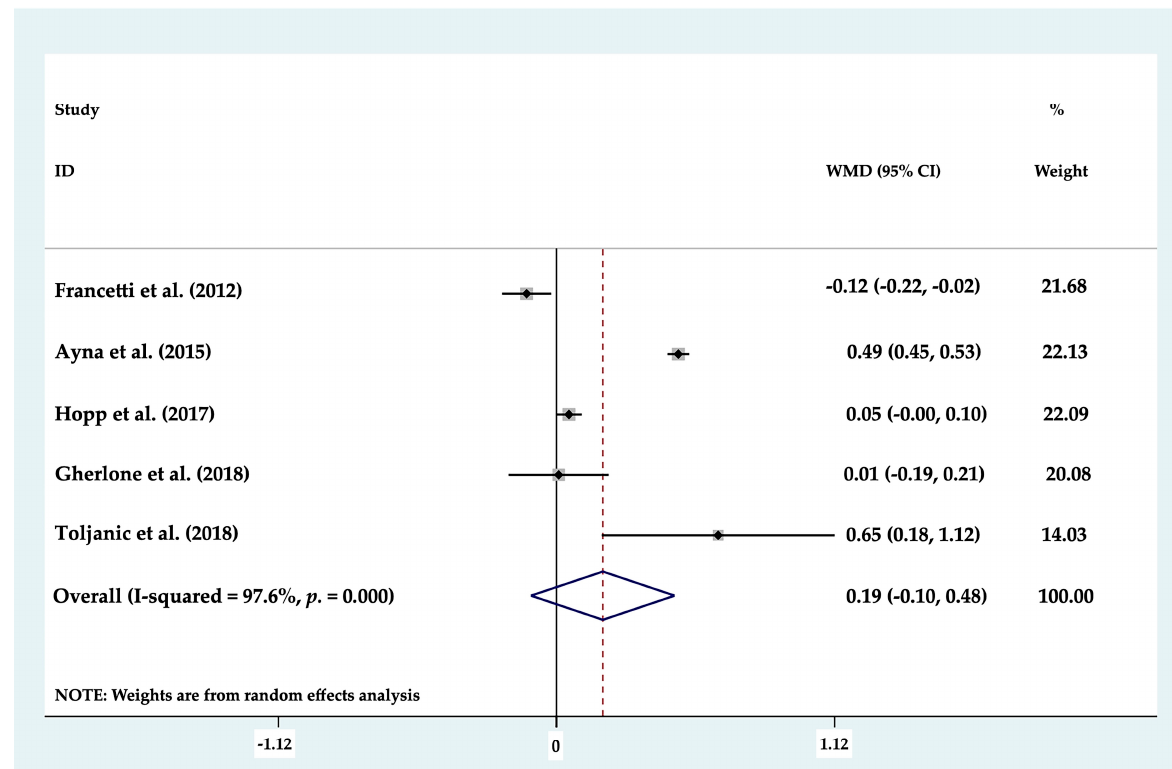
Figure 4. Forest plot of marginal bone loss in full arch restorations. No statistically significant differences ( p ≥ 0.05) were found.